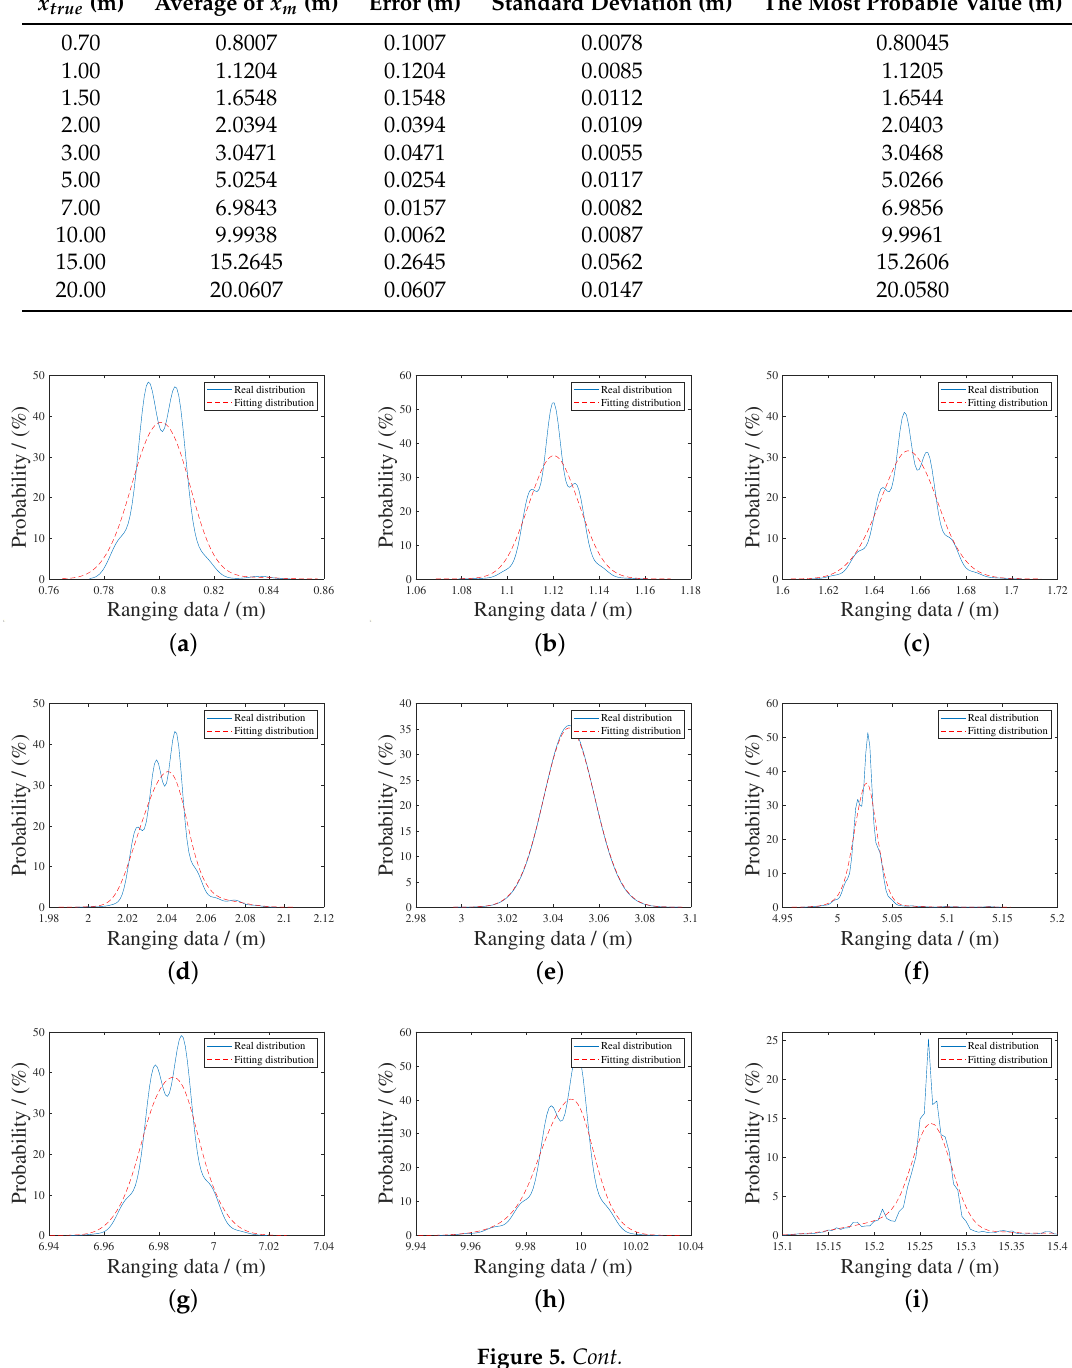
Table 1. Results of the ranging